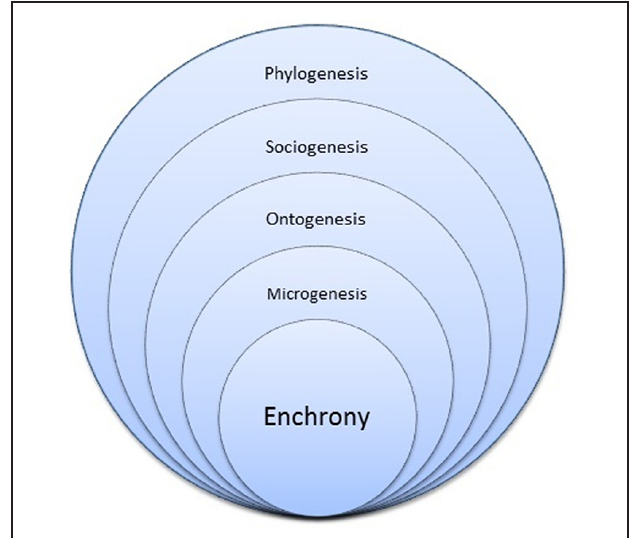
FIGURE 2 | Time scales of human evolution and development. Figure © Chris